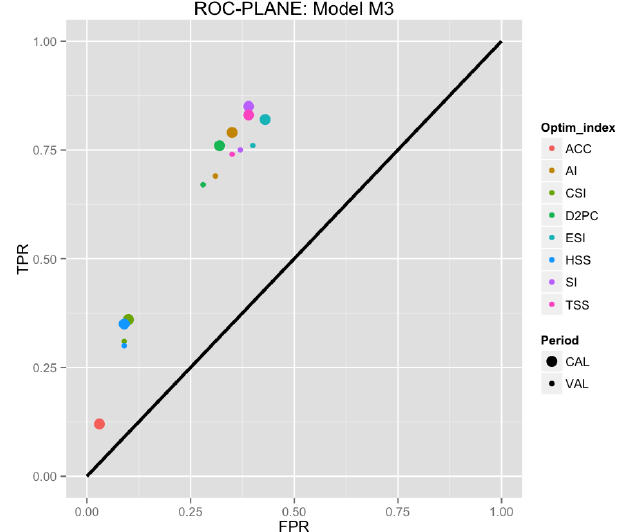
Figure B3. Models’ performance results in the ROC plane for